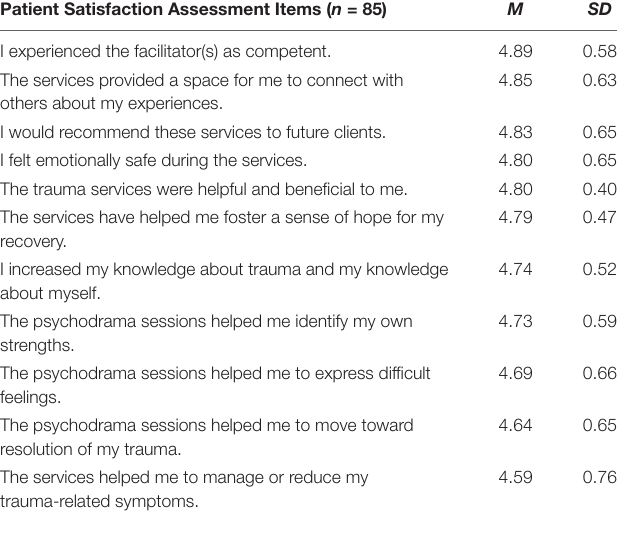
TABLE 4 | Frequency Data for Patient’s Experience and Level of Satisfaction Open-ended